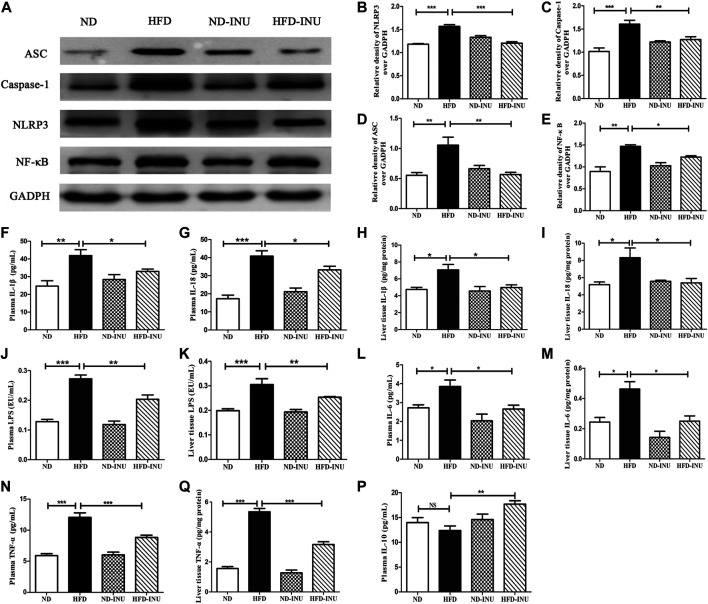
Effects of INU treatment on NLRP3 inflammasome, NF-κB and inflammatory indications in NAFLD. (A) Western blot analysis of NLRP3, ASC, Caspase-1 and NF-κB. Semi-quantitative analysis of the relative levels of NLRP3 (B), Caspase-1 (C), ASC (D) and NF-κB (E) by densitometric analysis. Levels of liver and plasma IL-1β (F,H), IL-18 (G,I), LPS (J,K), IL-6 (L,M), TNF-α (N,O) as well as plasma IL-10 (P) were determined using ELISA kits, respectively. Data are expressed as mean ± SEM; NS: no significant difference. *p < 0.05, **p < 0.01, ***p < 0.001. All experiments were performed in triplicate. NLRP3: nod-like receptor protein 3; ASC: apoptosis-associated speck-like protein; NF-κB: nuclear factor-κB; IL: interleukin; LPS: lipopolysaccharide; TNF-α: tumor necrosis factor-α; INU: inulin; ND: normal diet; HFD: high-fat diet.